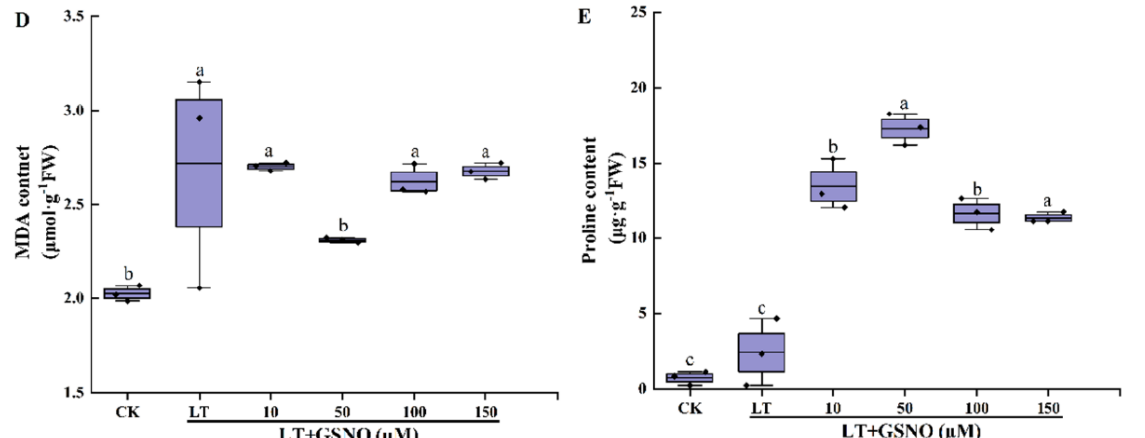
Figure 2. The effects of different concentrations of GSNO on the phenotype, leaf area, chlorophyll content, MDA and proline content of mini Chinese cabbage under low temperature stress. Five-leaf seedlings were treated with CK (26/18 °C, day/night), LT (4/4 °C, day/night) and different concentrations of GSNO (0, 10, 50, 100 and 150 µM) under low-temperature stress. The leaves were sprayed with GSNO once a day for 3 d and treated for 7 d. After 7 d, leaf area, chlorophyll content, MDA and proline contents were measured, respectively. ( A ) Phenotype and leaf size of the third leaf from outside to inside after treating for 7 d; ( B ) Leaf area of the third leaf from outside to inside; ( C ) Chlorophyll content; ( D ) MDA content; ( E ) Proline content. Different lowercase letters above the error bars indicate significant differences at the 0.05 level ( p ≤ 0.05).